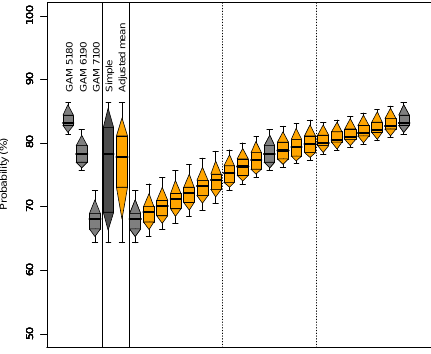
Figure A4. Confidence intervals on probabilities of all palsa areas becoming unsuitable by 2080-2100 estimated with GAM ensembles calibrated for different baseline periods (1951-80, 1990, 1971–2000; gray boxplots), two approaches for estimating 1961-90, 1971-2000; gray boxplots), two approaches for estimating the combined parameter and initial conditions uncertainty by a simple sum of the individual distributions (darkgray the combined parameter and initial conditions uncertainty by a sim- boxplots) and by summing re-sampled distributions with adjusted mean (orange boxplots). ple sum of the individual distributions (darkgray boxplots) and by Probabilities were estimated by evaluating the impact response surface for the Grand summing re-sampled distributions with adjusted mean (orange box- Ensemble (n=10000) with SRES A1B forcing. Boxplots show lower quartile, median and plots). Probabilities were estimated by evaluating the impact re- upper quartile; triangle peaks show the 5 th and 95 th percentiles (defining 90% confidence intervals); whiskers delimit the smallest and largest values. sponse surface for the Grand Ensemble ( n =10000) with SRES A1B forcing. Boxplots show lower quartile, median and upper quartile; triangle peaks show the 5th and 95th percentiles (defin- ing 90% confidence intervals); whiskers delimit the smallest and largest